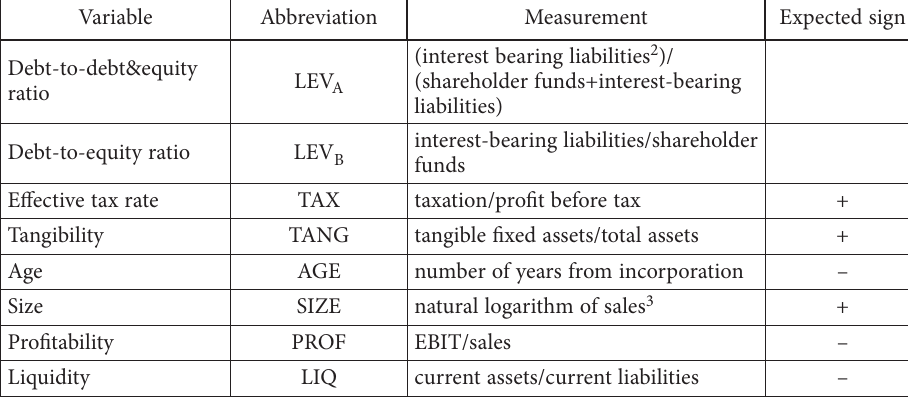
Table 3. Description of selected variables Variable